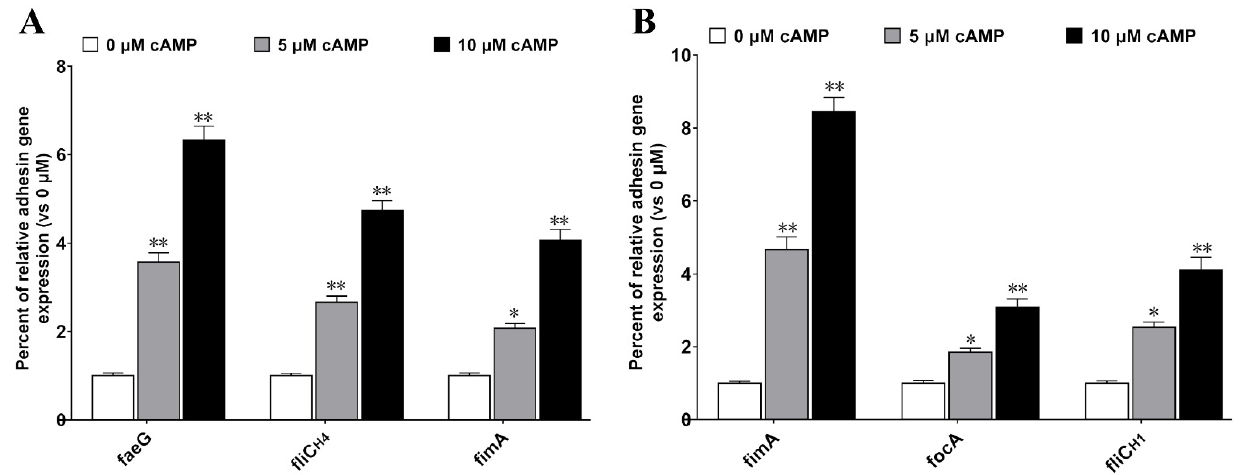
Figure 5. Exogenously supplied 5 μ M and 10 μ M cAMP up-regulates the adhesion molecules mRNA expression of E. coli 1836-2 and EcNc. ( A ) Treatment with cAMP increases the expression of faeG , fliC H4 , and fimA genes of ETEC 1836-2. The mRNA level of faeG , fliC H4 , and fimA without cAMP treatment was considered 100%. ( B ) Treatment with cAMP increases the expression of fimA , focA , and fliC H1 genes of E. coli EcNc. The mRNA level of fimA , focA , and fliC H1 without cAMP treatment was considered 100%. The data are expressed as the mean ± SD of four independent experiments. * indicates p < 0.05 and is deemed statistically significant. ** indicates p < 0.01 and is deemed statisti- cally highly significant.